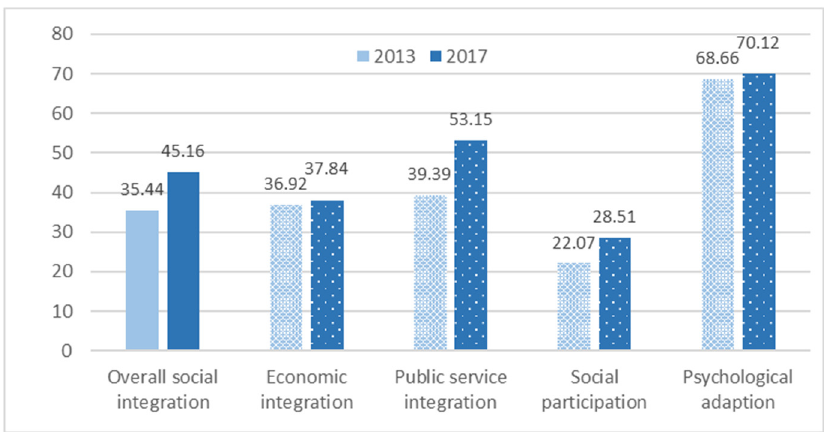
Figure 7. Migrants’ social integration in Wuhan (years 2013 and 2017).